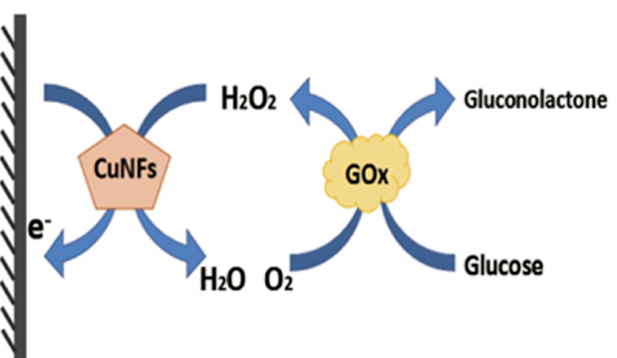
Figure 14. Mechanism of the fabricated Cu nanoflower glucose sensor [111]. Copyright: Elsevier B.V.